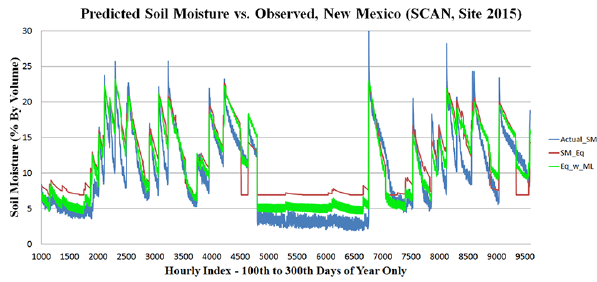
Figure 5. Soil moisture time series, SCAN site 2013, Georgia (USA), line colors from Fig. 3. Actual soil moisture (blue line), diagnostic soil moisture equation estimate (red line), and diagnostic soil moisture equation with ML error correction (green line). Hy- droclimate: LWC (low seasonality, winter peak precipitation, winter peak runoff). Soil texture: sandy